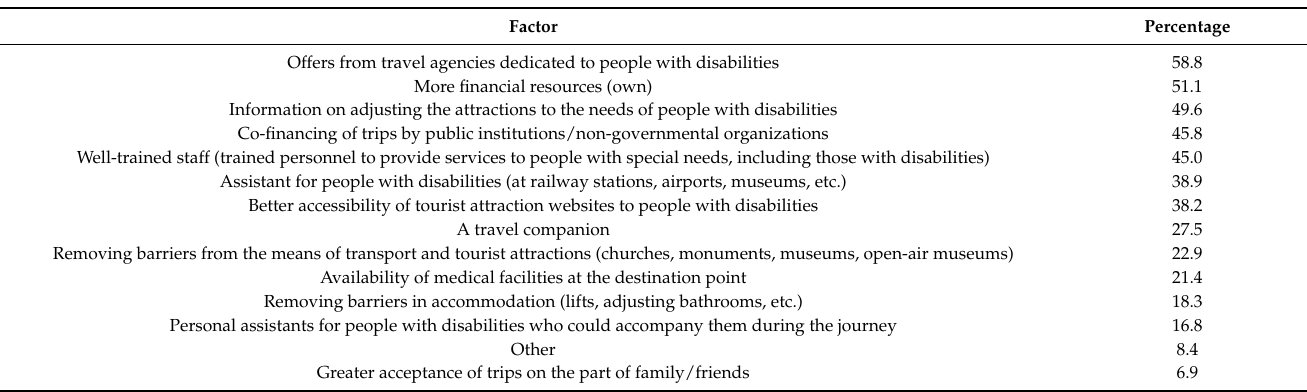
Table 5. Factors that would make travelling